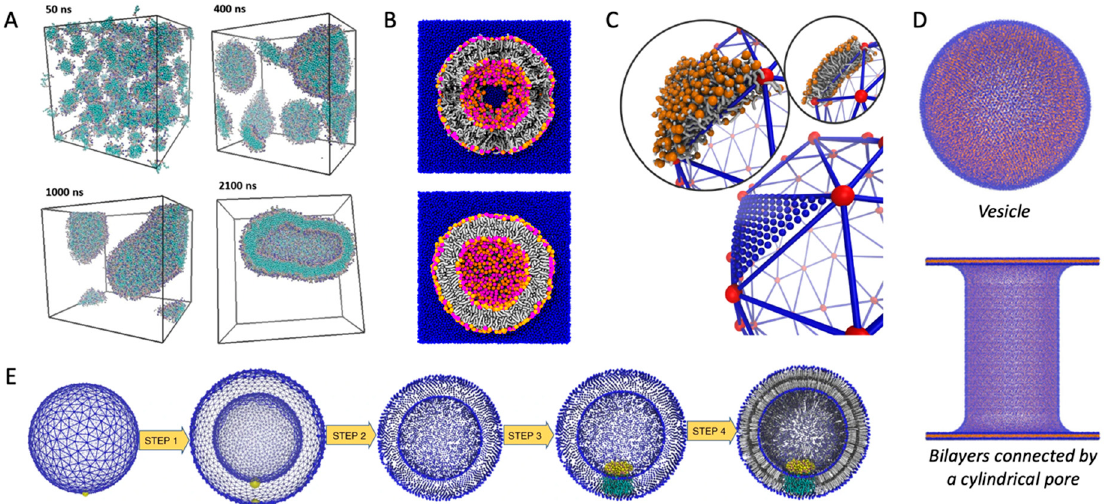
Figure 3. Methods for vesicle generation. ( A ) Self-assembly of vesicle, adapted from Ref. [35]. ( B ) CHARMM-GUI Martini Maker, adapted from Ref. [36]. Top shows the cross-section of a vesicle with pores for lipid translocation between leaflets, bottom shows the vesicle after pore-closure. ( C ) Generation of vesicles by triangular surfaces, using TS2CG. Adapted with permission from Ref. [5] (copyright 2015, ACS Publications). ( D ) Curvature generated from transition of a flat membrane, using BUMPy. Adapted from Ref. [37]. ( E ) Insertion of membrane protein in a vesicle, using TS2CG. Adapted from Ref. [5]. If not stated otherwise, the original figures are published under a creative common license.